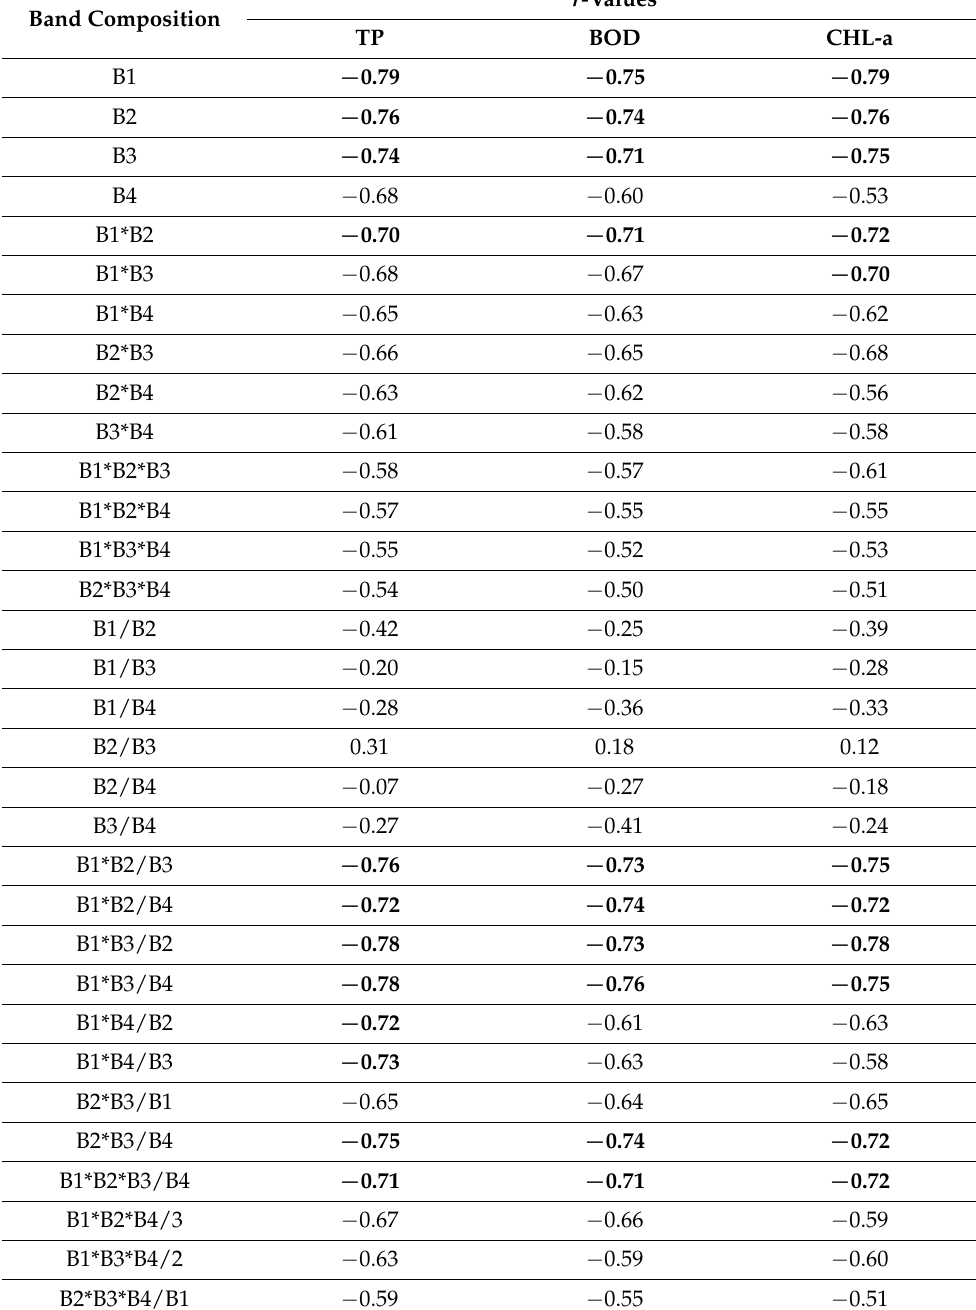
Table 3. Correlation matrix values for different band compositions of Landsat 5 TM with TP, BOD and CHL-a (B1: Blue, B2: Green, B3: Red, B4: NIR-Near-Infrared, TP: Total Phosphorus, BOD: Biological Oxygen Demand, CHL-a: Chlorophyll-a, influential bands and band compositions have been ( r ≥ 0.7) marked in